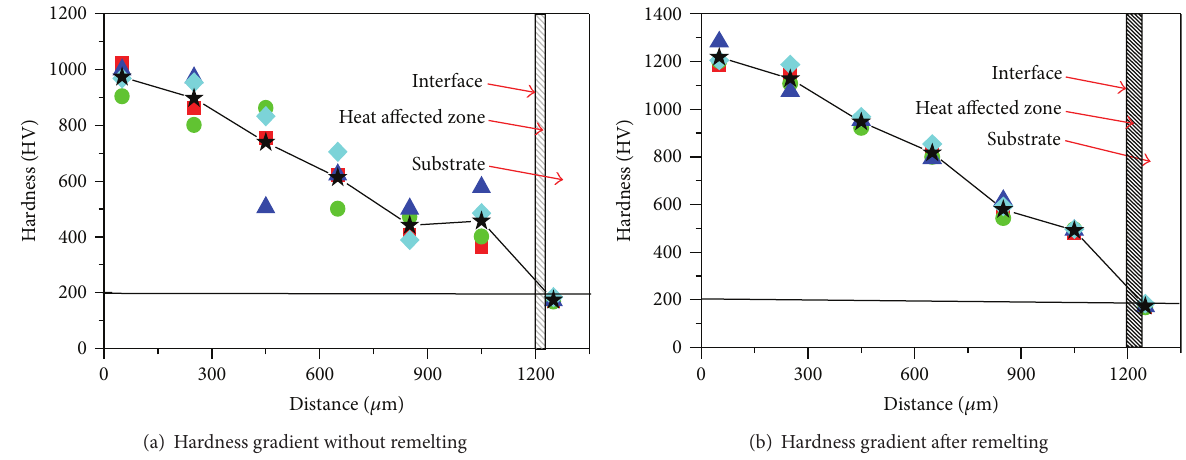
Figure 6: The hardness curves of the arc spraying and remelted